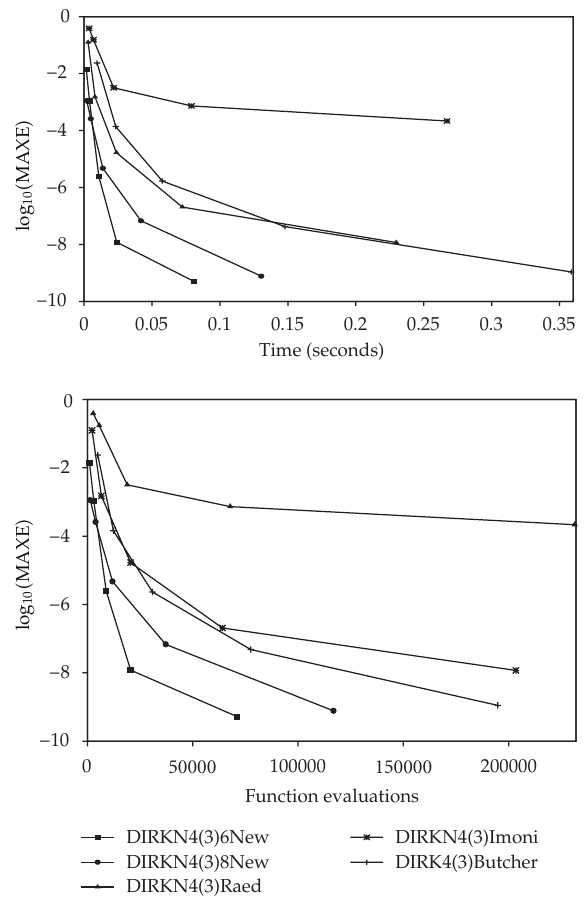
Figure 1: E ffi ciency curves for Problem